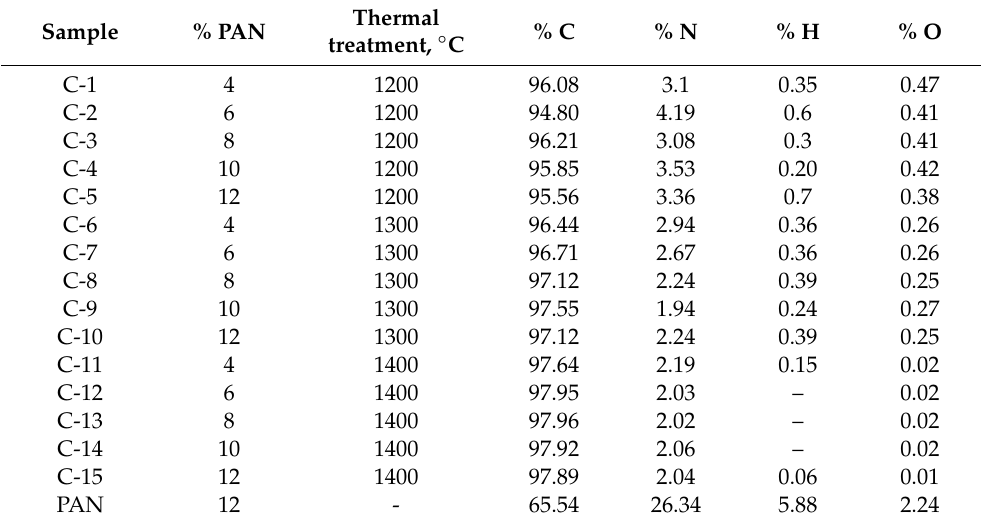
Table 1. Elementary composition of carbonized samples at various temperatures. Sample % PAN